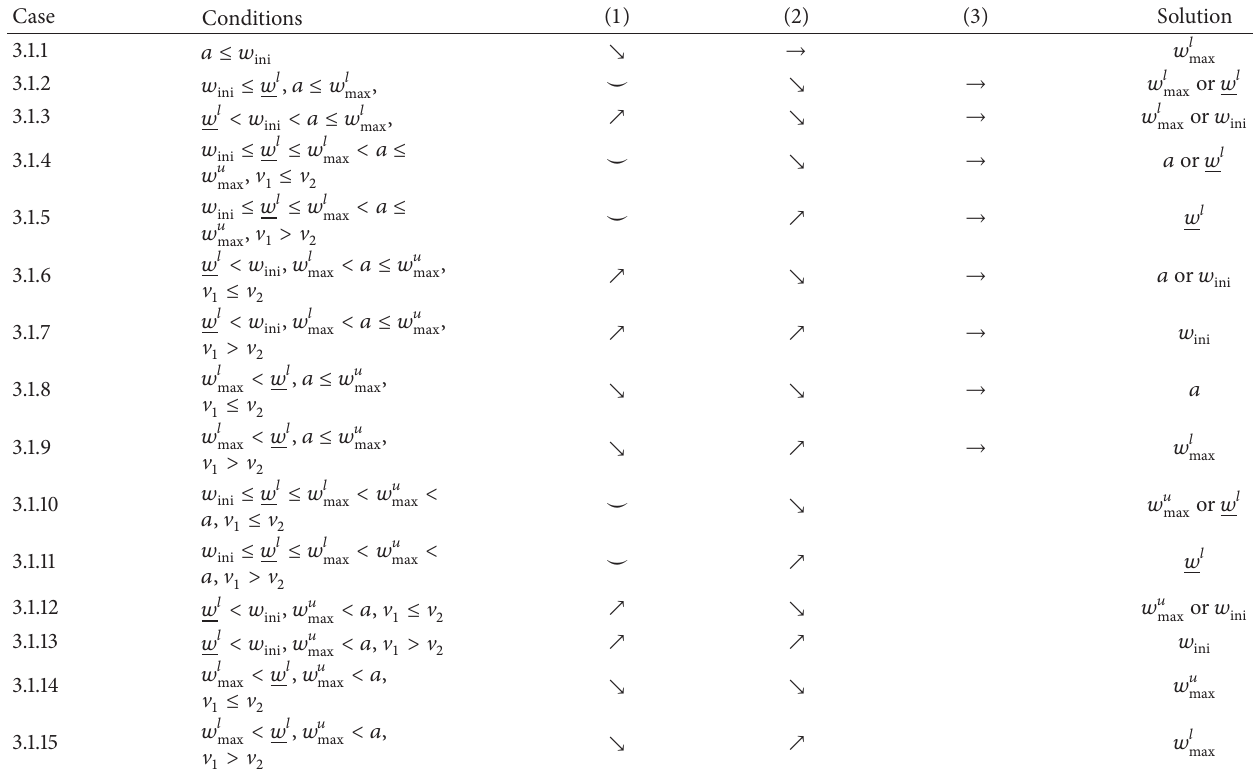
Table 9: Case 3.1